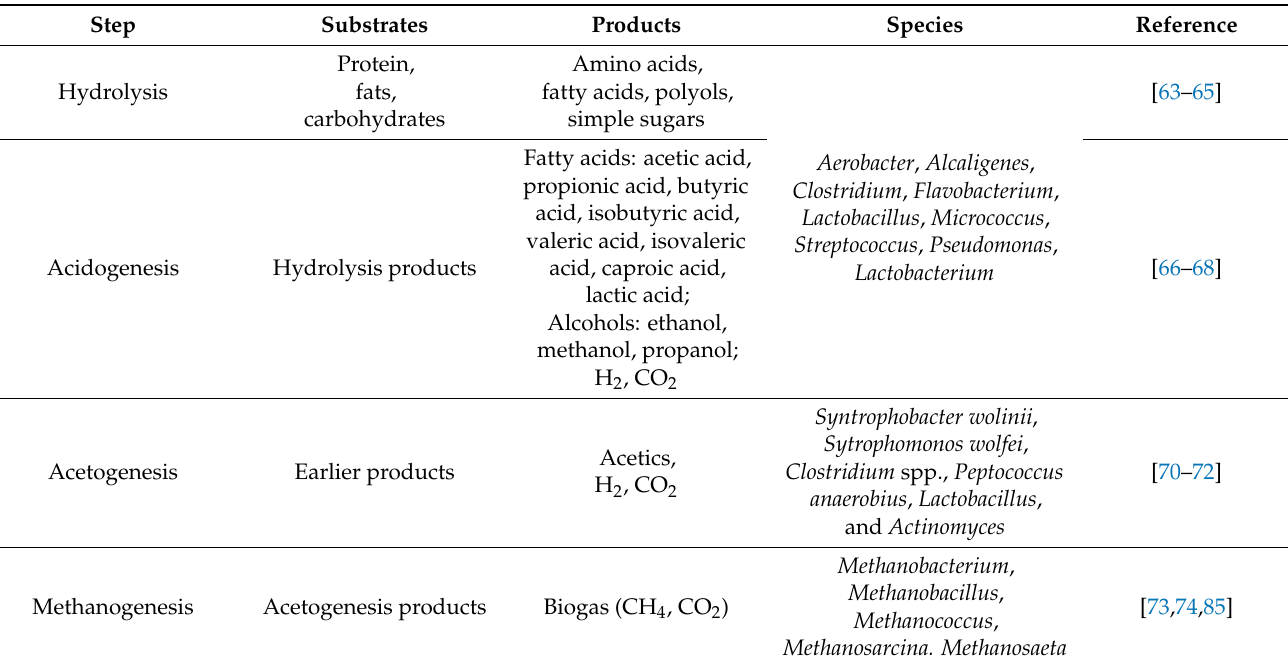
Table 3. Overview of AD